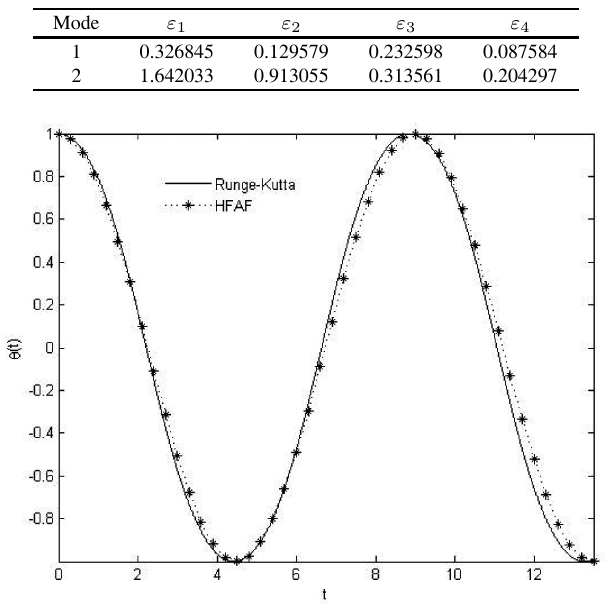
Table 2 Values of dimensionless parameters ε i in Eq. (17), for two modes